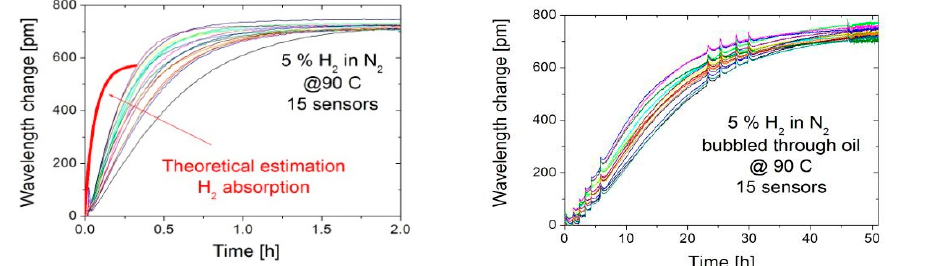
Figure 3. Response of fifteen parallel processed sensors to 5% H 2 in N 2 gas mixture ( left ) and the same gas bubbled trough oil ( right ) both at 90